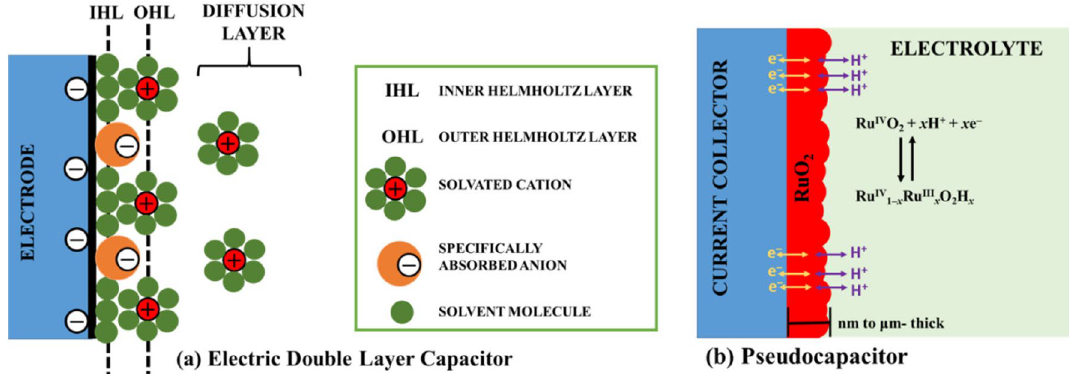
Figure 1. Schematic diagram of supercapacitors: ( a ) Electric double-layer capacitor (EDLC); ( b ) example of pseudocapacitor based on ruthenium